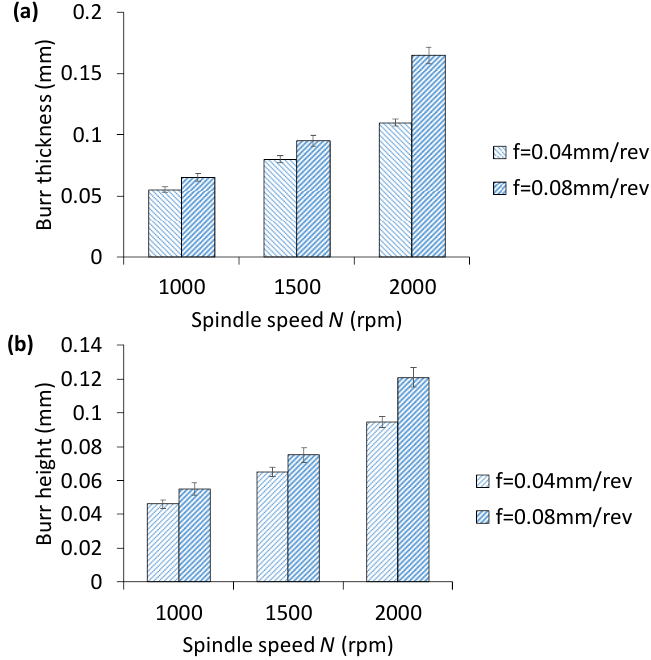
Figure 8. Effect of spindle speed and feedrate on ( a ) thickness and ( b ) height of exit burr. Error bar indicates standard deviation of burr size for drilling of 10 holes